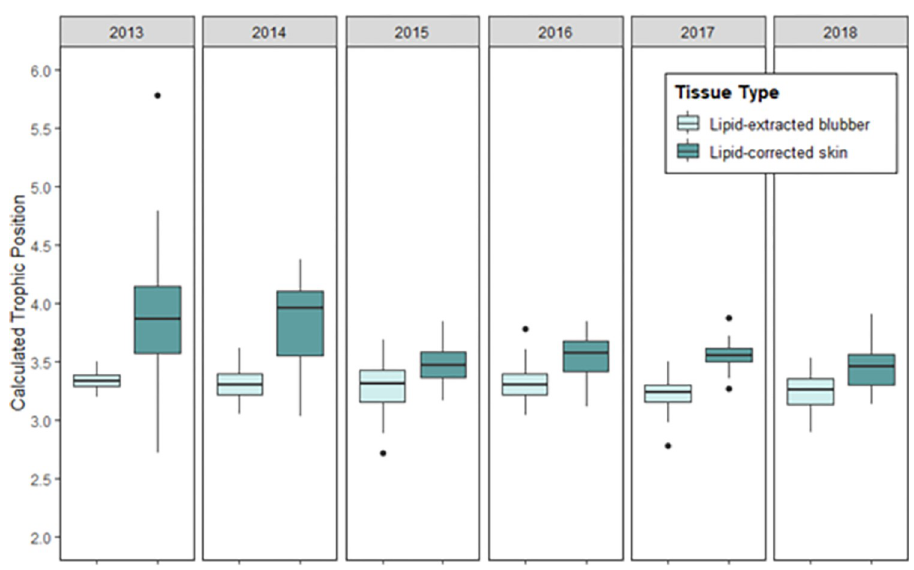
Fig 3. Trophic position estimates for blubber and skin tissue across sample years; 2013–2018.